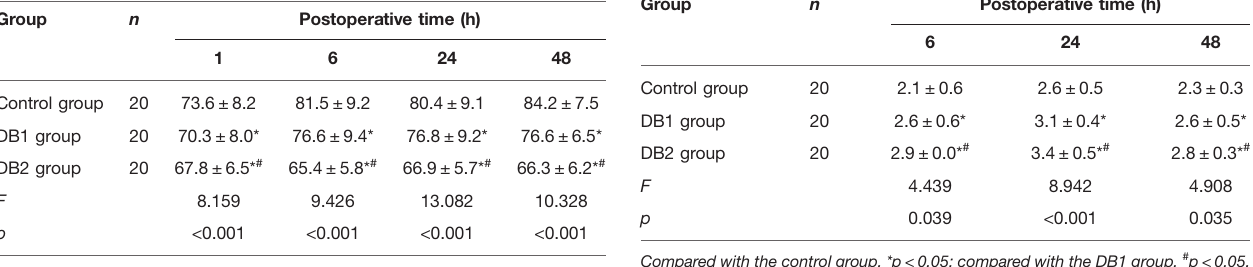
TABLE 4 | Comparison of the heart rate of puerperae at different times after surgery among three groups (mean±SD, n /min). Group